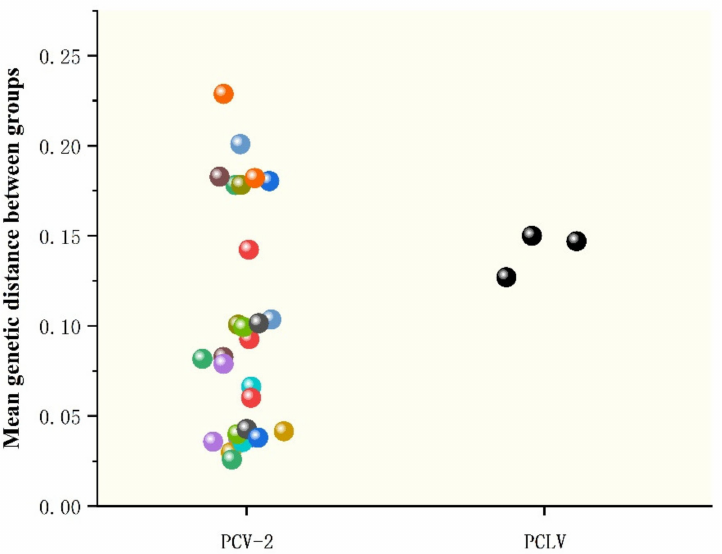
Figure 5. Genetic distance analysis between PCLV and PCV2. The genotypes of PCV refer to the classification of Marina Sibila et al. [28], including 2a, 2b, 2c, 2d, 2e, 2f, 2g and 2h. Genetic distance was calculated using MEGA X with a p-distance model and 1000 bootstrap